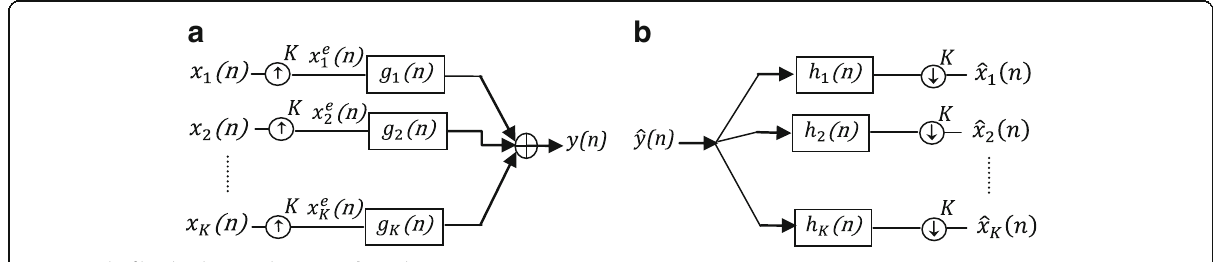
Fig. 2 Cyclic filter bank. a Synthesis part. b Analysis